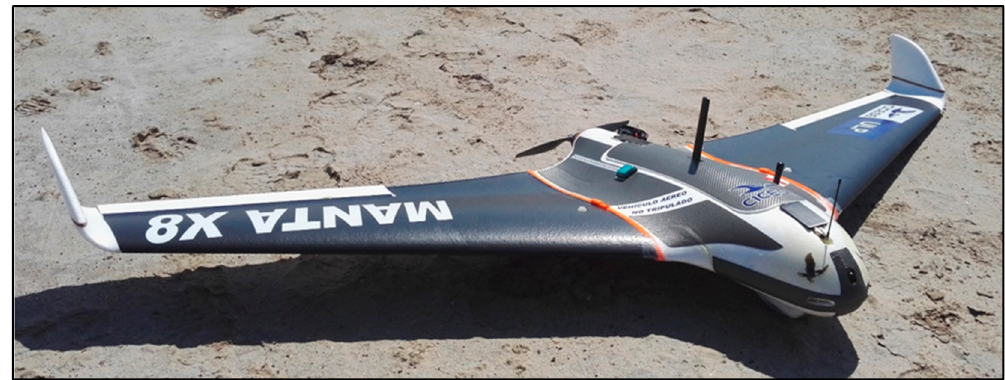
Figure 11. Delta Wing UAV used in the SIMMA project.